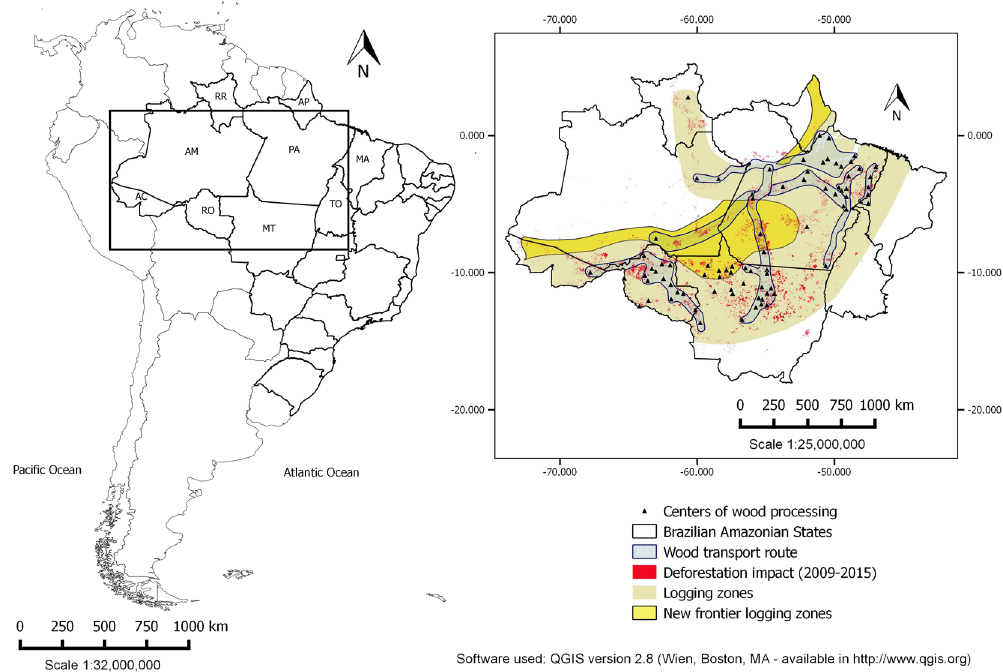
Figure 1. Map of the geographical area studied. Highlighted: Brazilian Amazonian states and the areas of timber distribution, deforestation/degradation, and connectivity between regions of forest exploitation and transport, commercial regions of established forestry production and new frontiers of